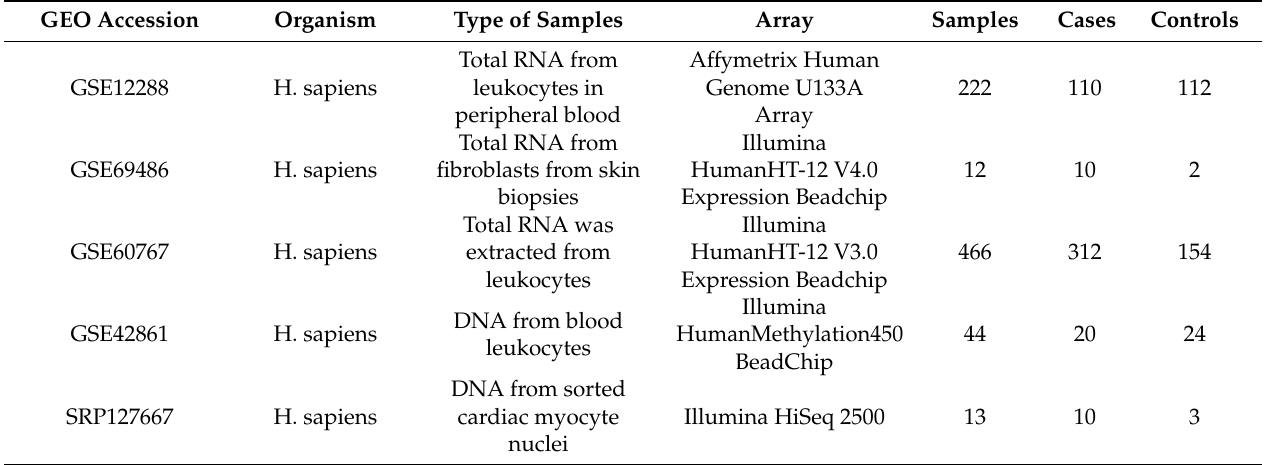
Table 2. GEO data sets used for